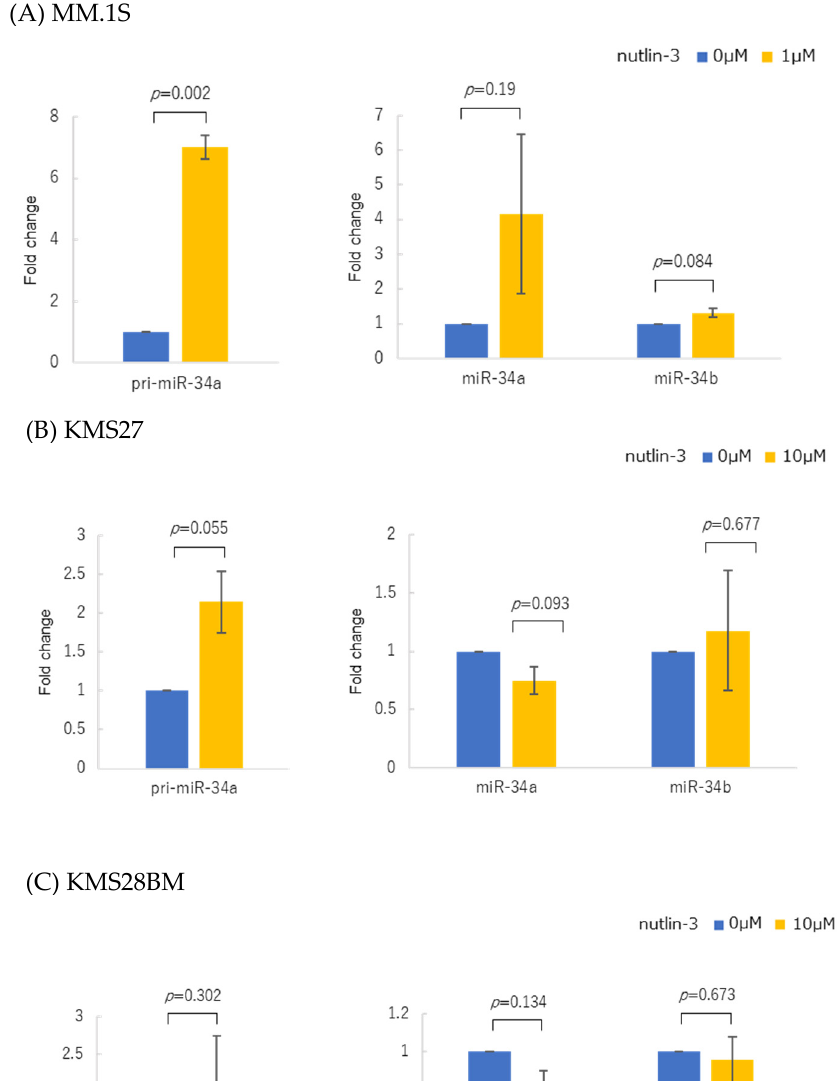
Figure 1. MiR-34 family and TP53 mRNA expressions. Box plots show each transcript’s expression. Y axis indicates delta-delta Ct value. Outliers are excluded from the plots. ( A ) miR-34a, ( B ) miR-34b, ( C ) TP53 . Correlations between miR-34 and TP53 expressions. ( D ) miR34a- TP53 , ( E ) miR-34b- TP53 . Each dot represents an individual patient.